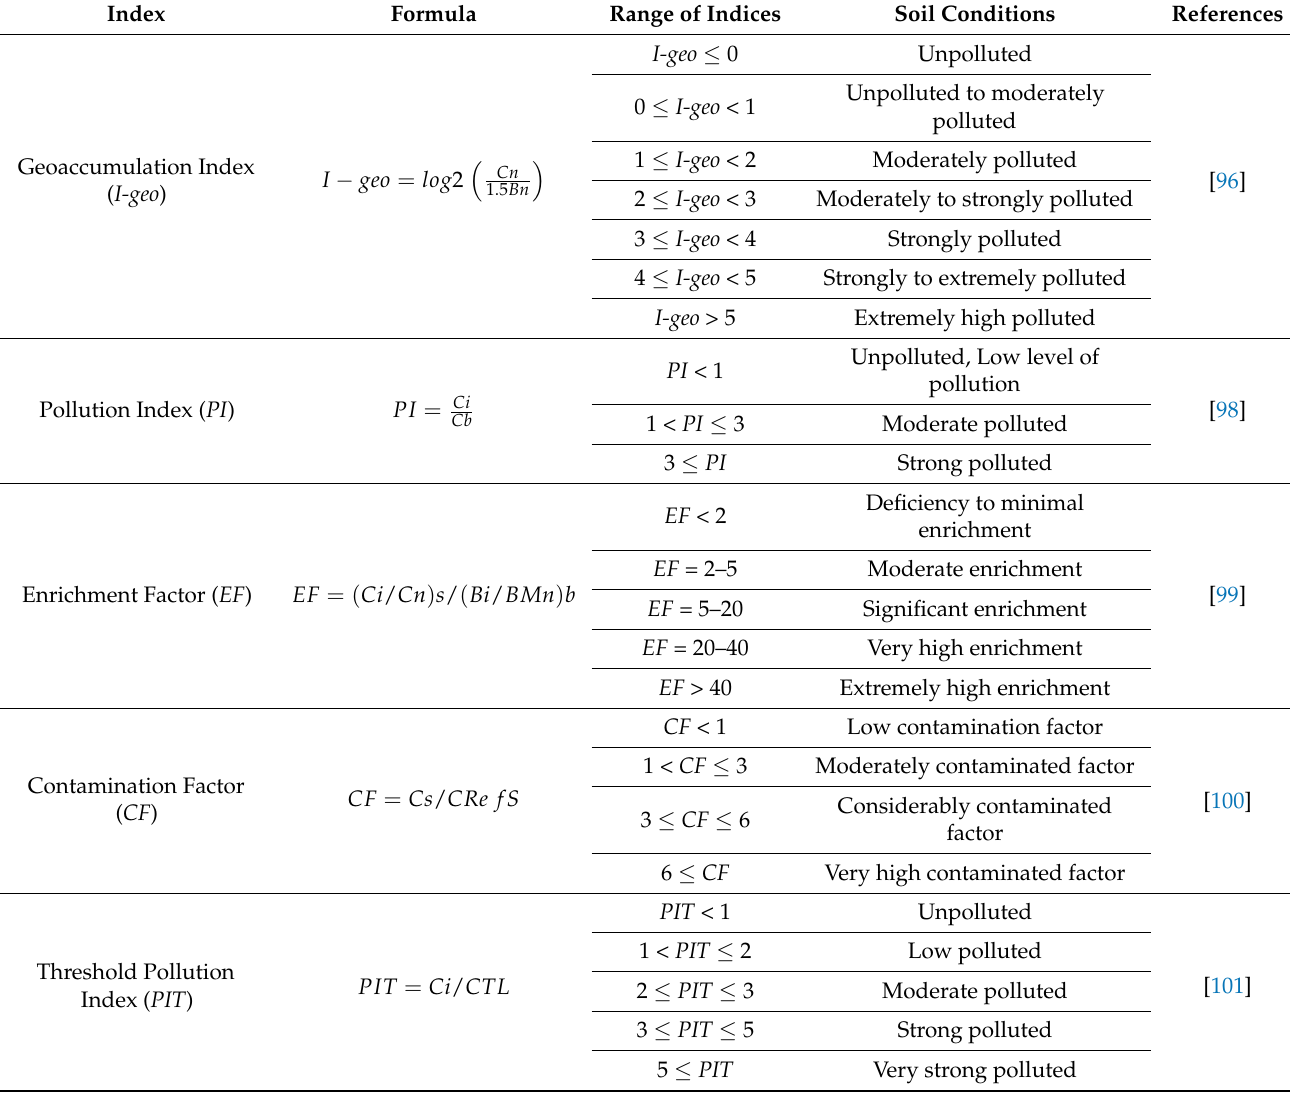
Table 1. Classes of single indices of